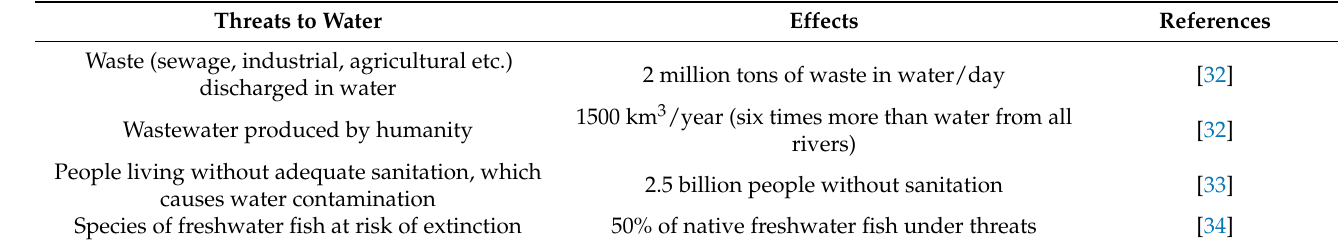
Table 1. Severe problems worldwide associated to water pollution.